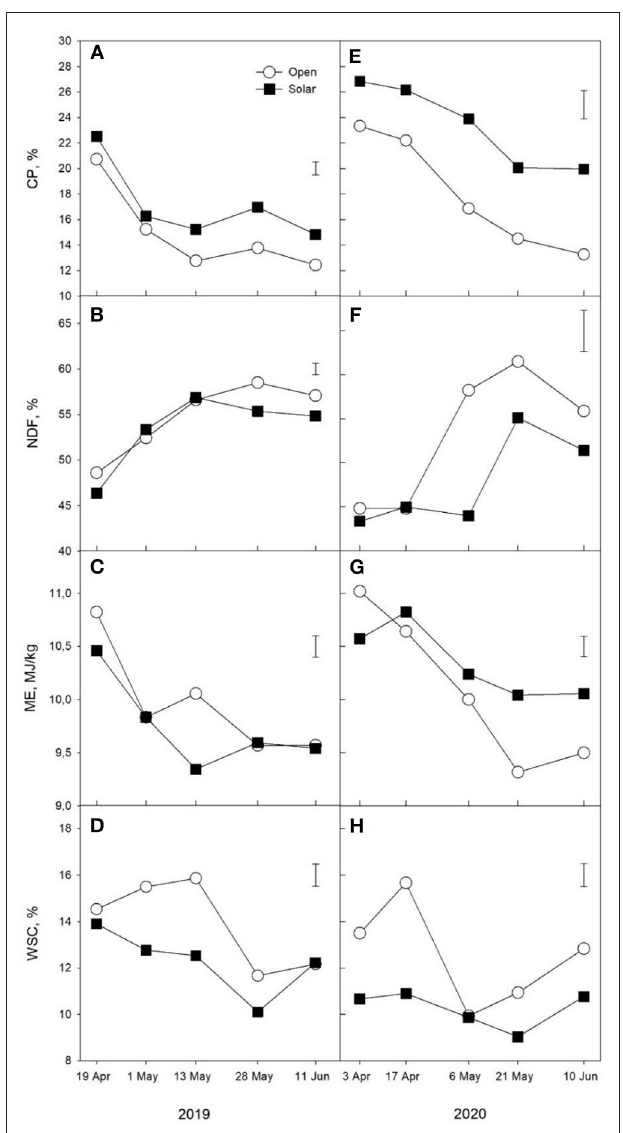
FIGURE 5 | Nutritive value of pasture on offer (%) in open and solar pastures in 2019 (A–D) and 2020 (E–H) . Bars represent SEM.